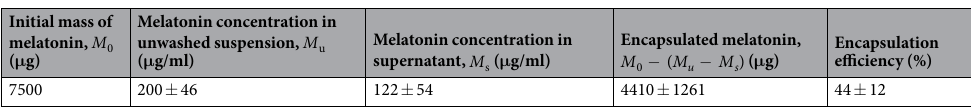
Initial mass of melatonin, M 0